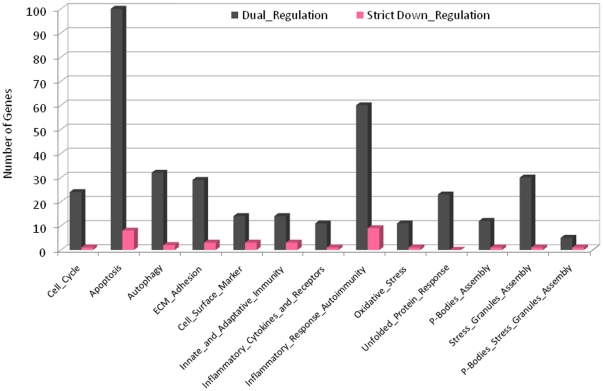
Alteration of miRNA expression in the colonic mucosa of UC and CD patients: in silico characterization of target transcripts.The exhaustive list of genes which are putatively targeted by the subset of 8 miRNAs that share common dysregulated expression both in quiescent UC and in quiescent CD was downloaded from the PITA catalog of predicted human microRNA targets (http://genie.weizmann.ac.il/pubs/mir07/mir07_data.html). The algorithm makes use of the parameter-free model for miRNA-target interaction described by Kertesz et al.
[75]. The total number of genes involved in each single biological process is computed. Strict down regulation (light purple) stands for genes, the 3′-UTR of which interacts only with up-regulated miRNA(s).